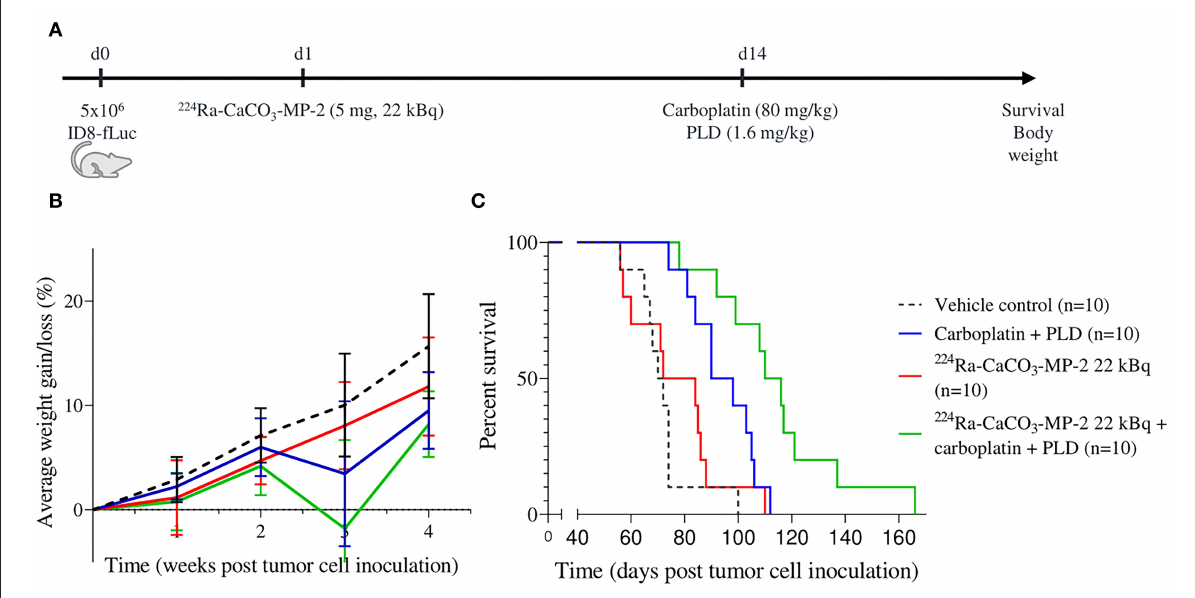
FIGURE3 Experimental set-up (A) with corresponding body weight evolution as a percentage of starting weight (B) and Kaplan-Meier curve for survival (C) of mice injected IP with vehicle control, 224 Ra-CaCO 3 -MP-2 (5mg, 22 kBq) on day 1 post tumor cell inoculation and/or carboplatin (80 mg/kg) and PLD (1.6 mg/kg) on day 14 post tumor cell